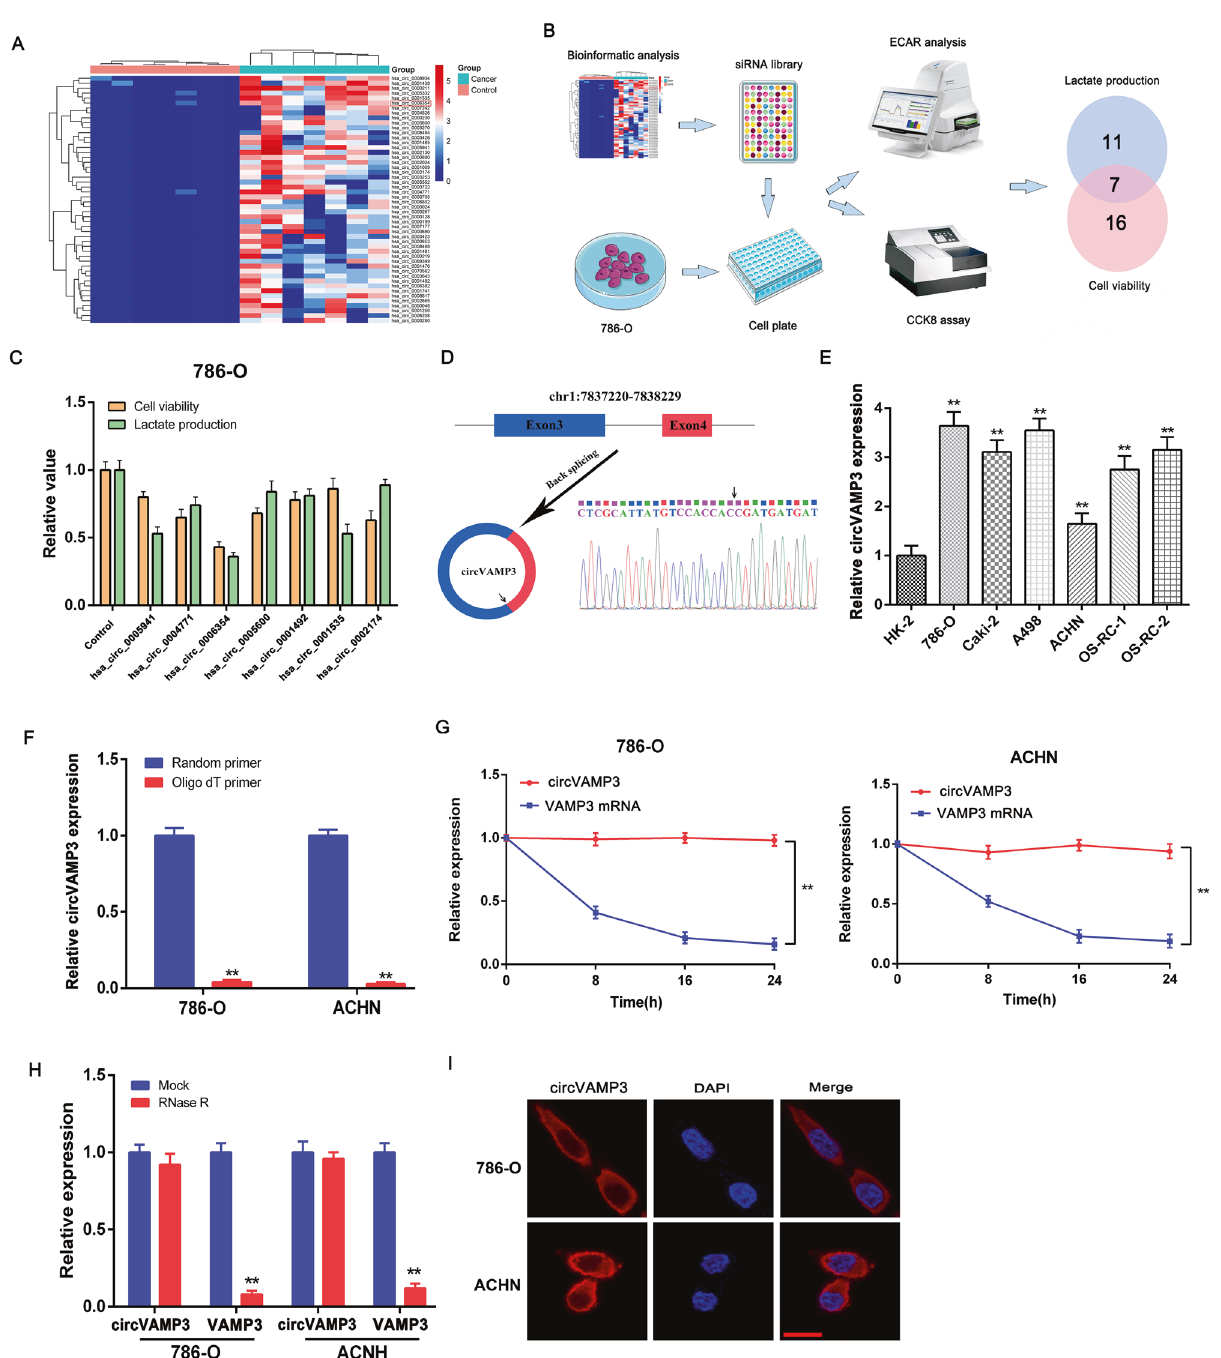
Fig. 1 Identi fi cation of circVAMP3 as a metabolism-related circRNA. A Top-50 circRNAs that are highly expressed in RCC according to the GEO dataset (GSE108735). B Flowchart for identi fi cation of circRNAs potentially involved in both glucose metabolism and cellular viability. C Seven circRNAs regulated both lactate production and cell viability in 786-O cells. D Scheme illustrating the production of circVAMP3 and sequencing analysis of back-splicing junction in circVAMP3. E Expression of circVAMP3 determined by qRT-PCR in RCC cell lines (786-O, Caki-2, A498, ACHN, OS-RC-1, and OS-RC-2) and in the normal human proximal tubule epithelial cell line (HK-2). F qRT-PCR of circVAMP3 in the reverse-transcribed products using random primers or oligo-dT primers. G Relative RNA levels assessed by qRT-PCR after actinomycin-D application. H RNA levels in cells with and without RNase R treatment. I FISH localization of circVAMP3. circVAMP3 was labeled with Cy3. Scale bar, 20 μ m. The results are presented as the mean ± SD. * P < 0.05; ** P < 0.01. addition, circVAMP3 overexpression enhanced the Y10 phosphor- genes, only FGFR1 knockdown reduced the LDHA Y10 phosphor- ylation of LDHA, which was blocked in a dose-dependent manner ylation level, while the other two tyrosine kinases had no effect on by the FGFR1 inhibitor PD-166866, suggesting that circVAMP3 p-LDHA (Fig. 6B). Therefore, FGFR1 was con fi rmed to be regulates Y10 phosphorylation of LDHA through FGFR1 (Fig. 6C). responsible for LDHA Y10 phosphorylation in RCC cells. In